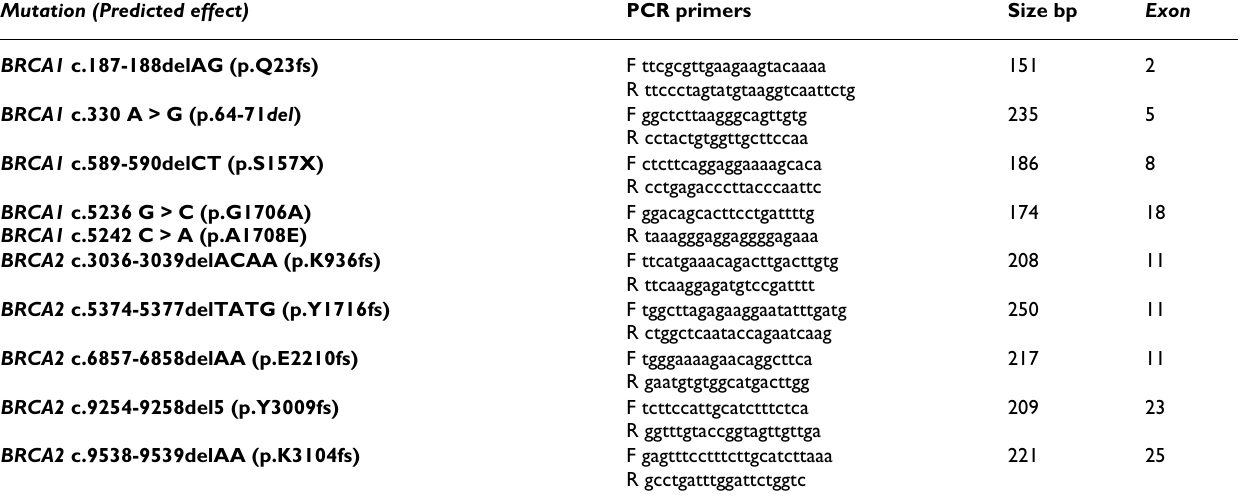
Table 1: PCR primer sequences (5' → 3') Mutation (Predicted